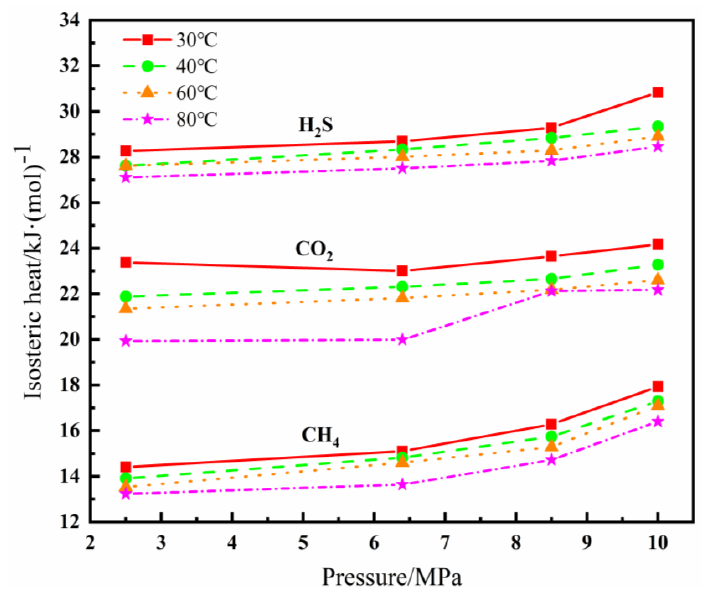
Figure 5. Isosteric heat of adsorption of gas molecules in PVDF at different conditions.